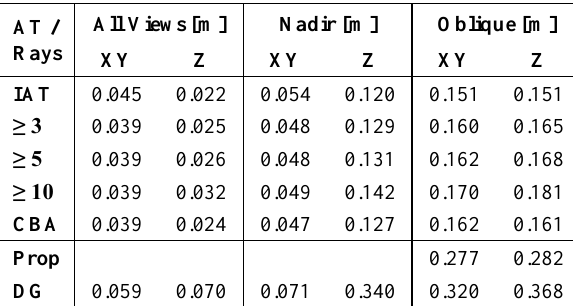
Table 2. Check point residuals (RMS values) for different AT approaches. For comparison, results from Direct Georeferencing (DG) and propagation of nadir corrections to oblique image orientations are